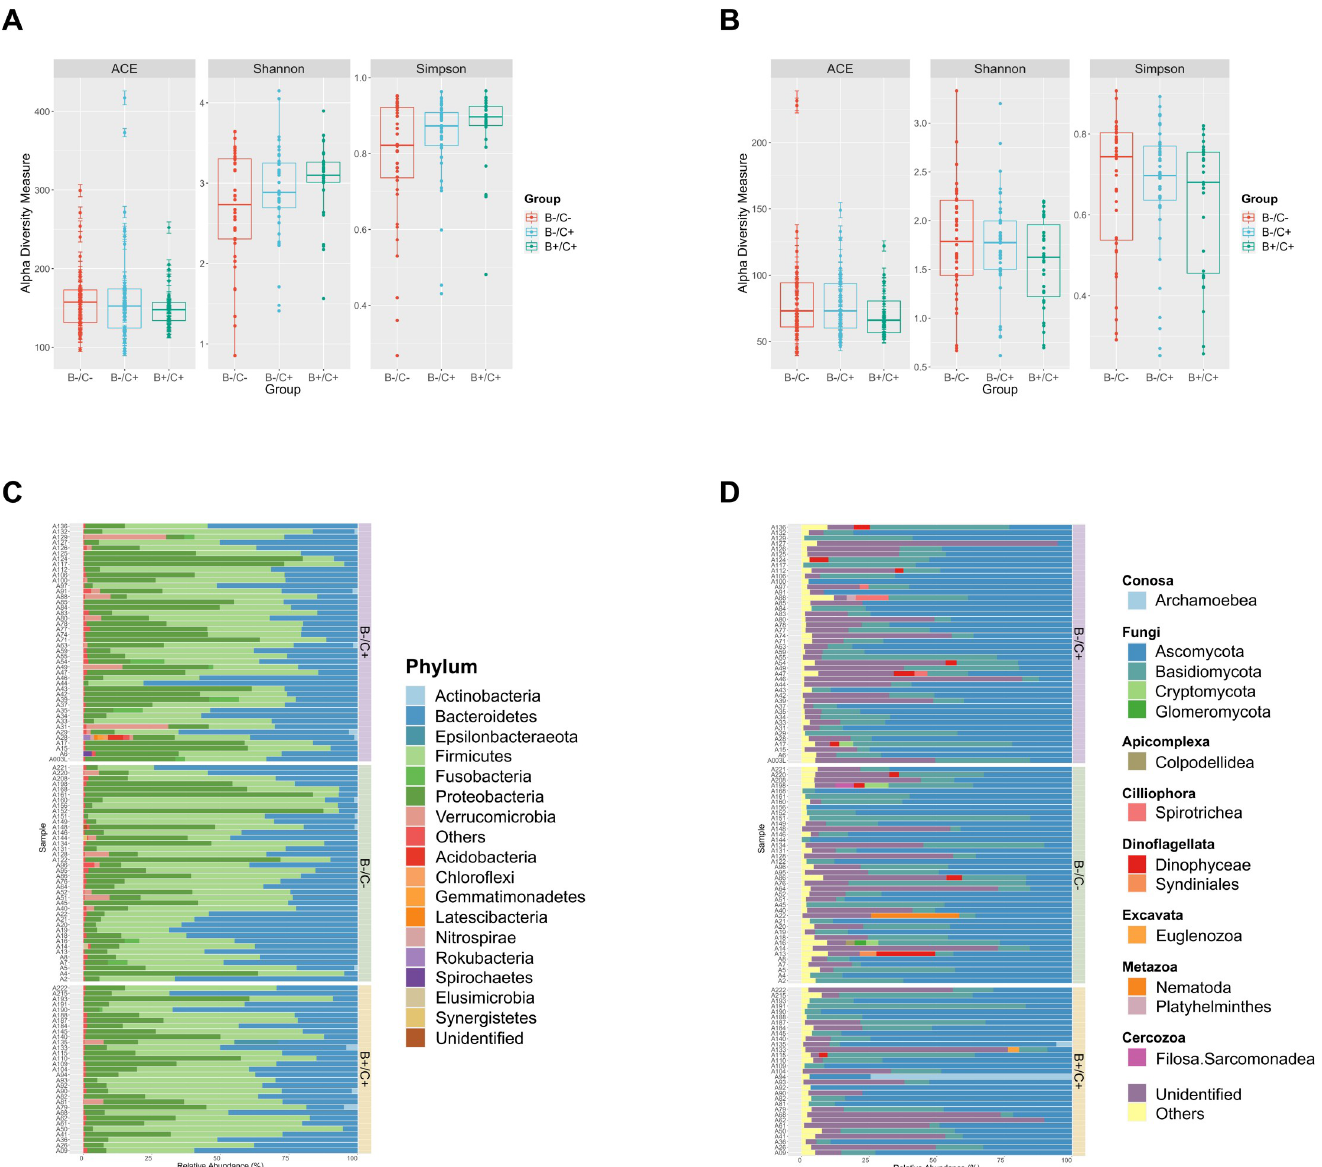
Fig 2. Alpha diversity measures and description of the bacterial phyla and eukaryotic divisions in the three groups. (A) Richness and abundance measures for the ASVs corresponding to bacterial communities of the three study groups and (B) Richness and abundance measures for the ASVs corresponding to eukaryotic communities of the three study groups. No significant differences were found in the richness and abundance of the bacterial and eukaryotic communities of the study groups (p < 0.05). (C) Relative abundance of bacterial phyla identified for each of the three study groups, where the predominant phyla within each group were Firmicutes, Bacteroidetes and Proteobacteria. (D) Relative abundance of the eukaryotic classes identified for each of the three study groups, where the predominant classes within each group were Ascomycota and Basidiomycota.